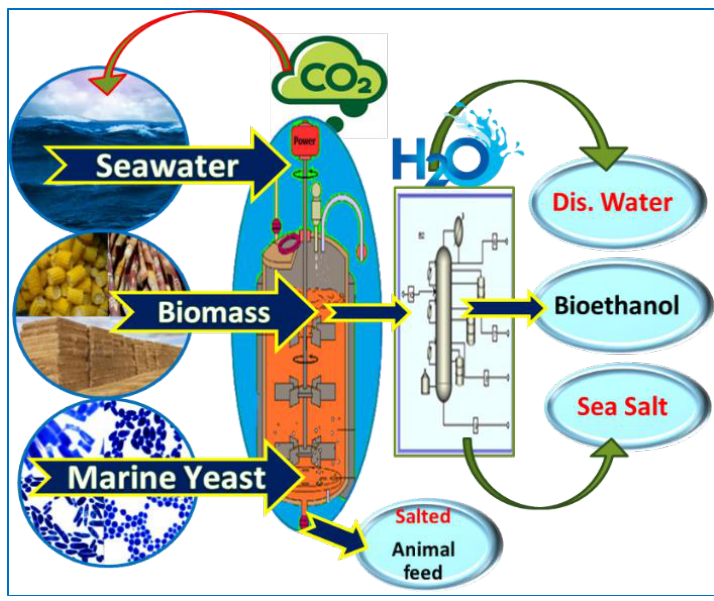
Figure 2. Coastal seawater biorefinery (CSB) system.